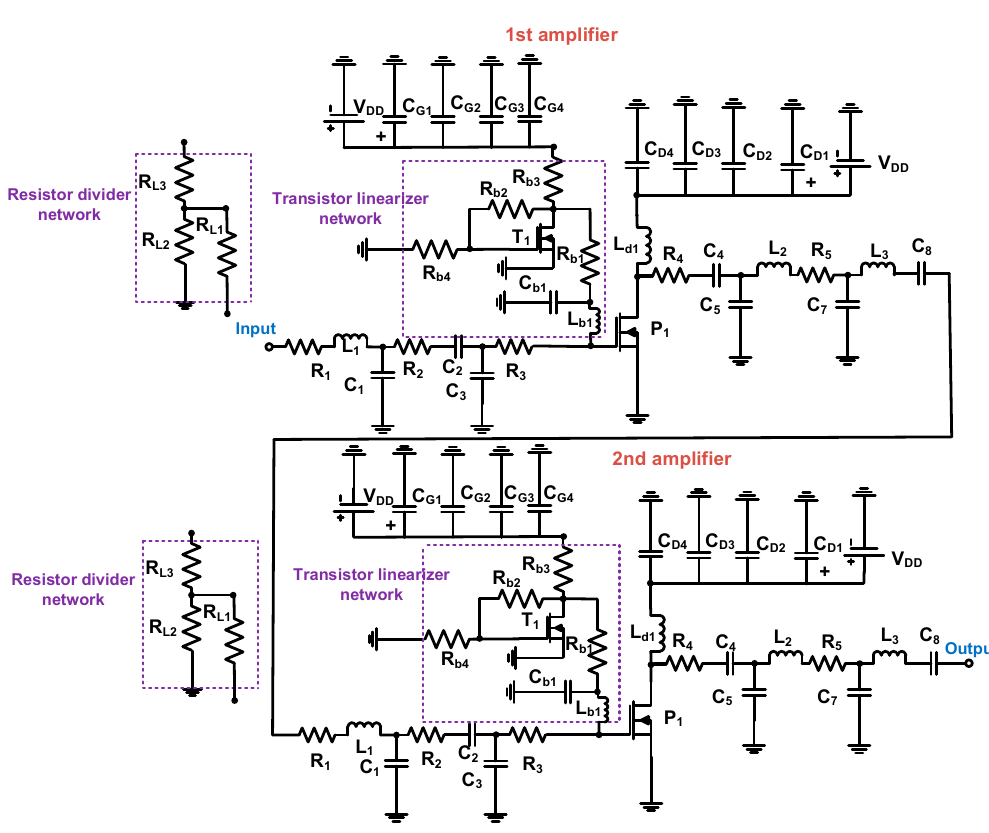
Figure 3. Schematic diagrams of class-C amplifiers with resistor divider network and transistor linearizer network .